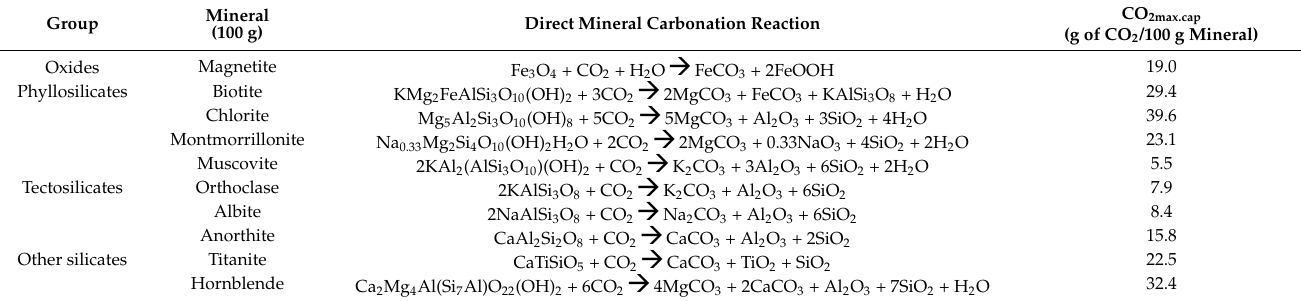
Table 3. Maximum theoretical mass of CO 2 in (g of CO 2 /100 g mineral) that can be sequestered by minerals. Group Mineral (100 g)